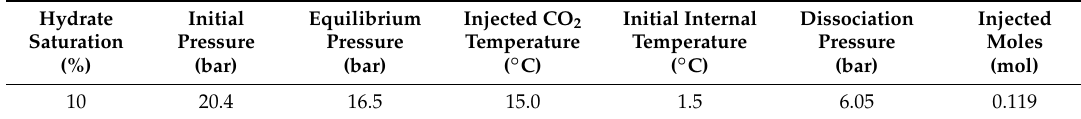
Table 4. Experimental parameters for CO 2 replacement test.